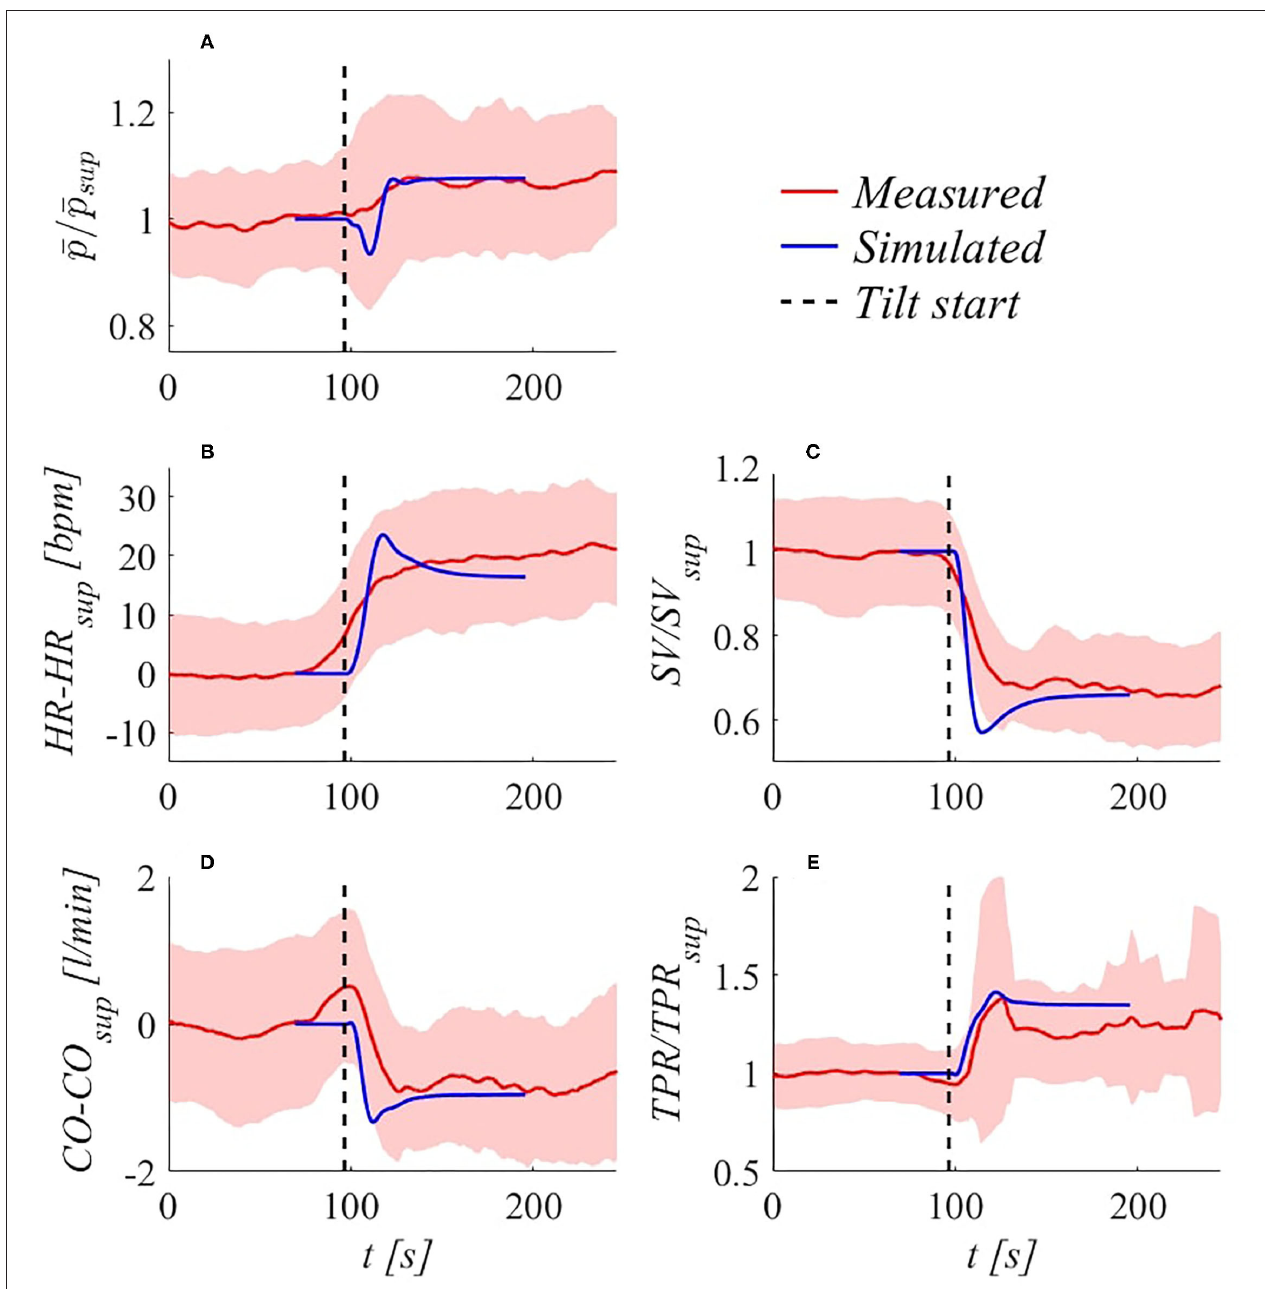
FIGURE 4 | Simulated (blue) and experimental (red, with SD bands) transient hemodynamic response following 70 ◦ HUT at 4 ◦ /s: (A) brachial ¯ p / ¯ p sup ( ¯ p denotes brachial MAP), (B) HR − HR sup , (C) SV / SV sup , (D) CO − CO sup , (E) TPR / TPR sup . Subscript sup refers to supine condition.